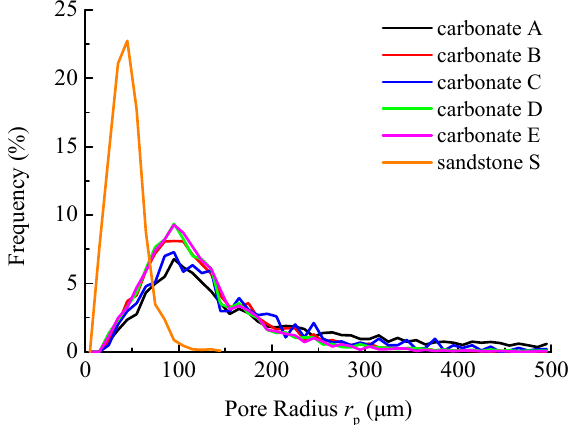
Figure 12. Distribution of pore radius in the REV2s of carbonate samples.